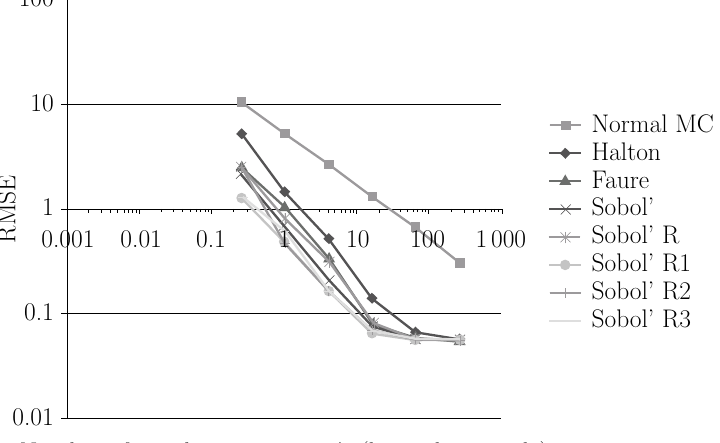
Figure 3: RMSE for different RLDSs over increasing values of n